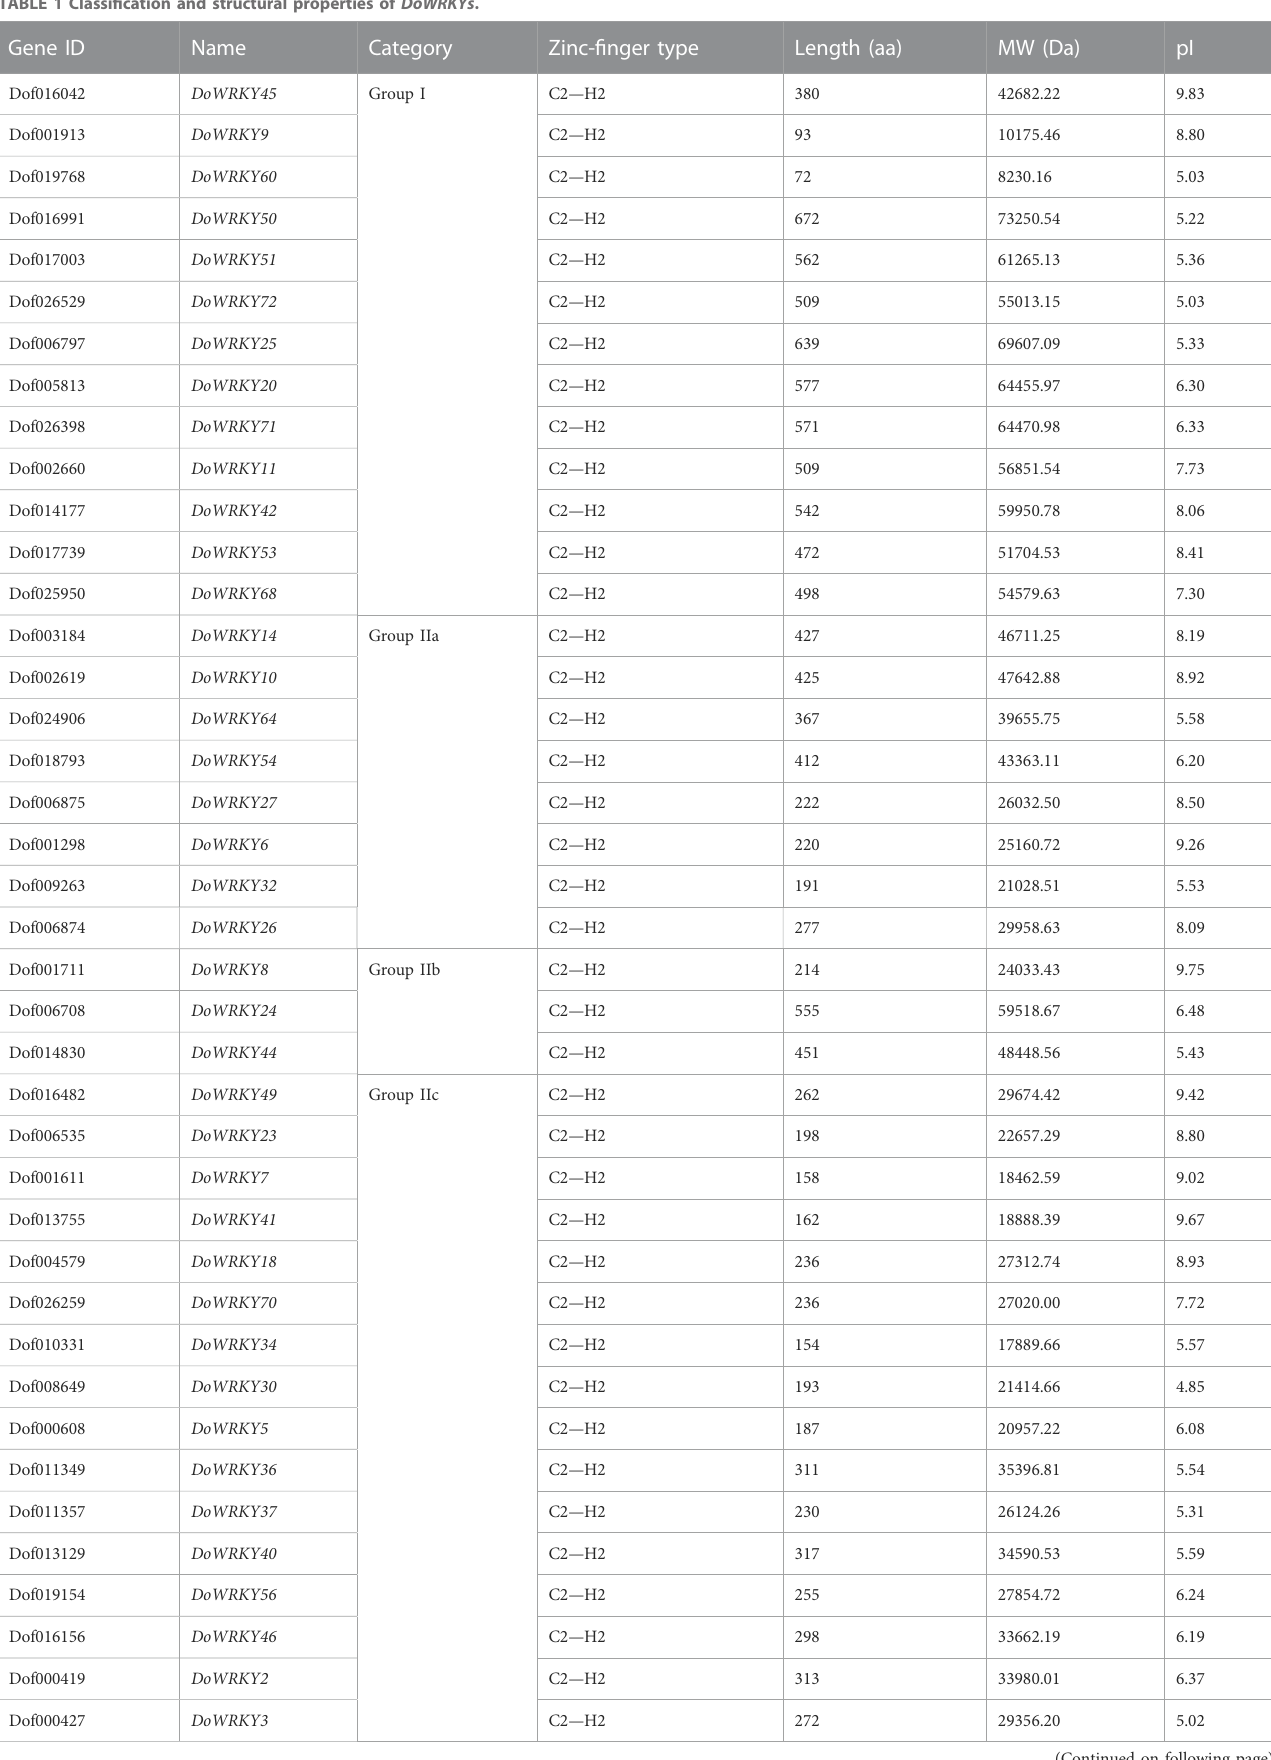
TABLE 1 Classi fi cation and structural properties of DoWRKYs